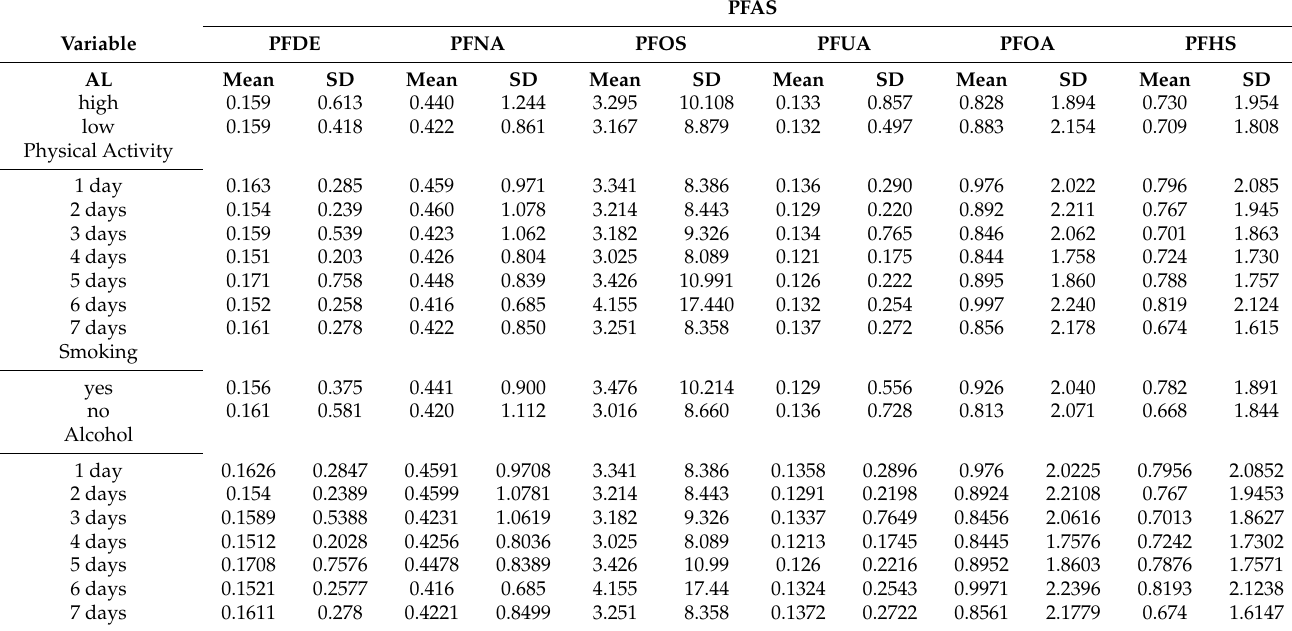
Table 2. PFASs mean and SD (standard deviation) by AL, and behavioral